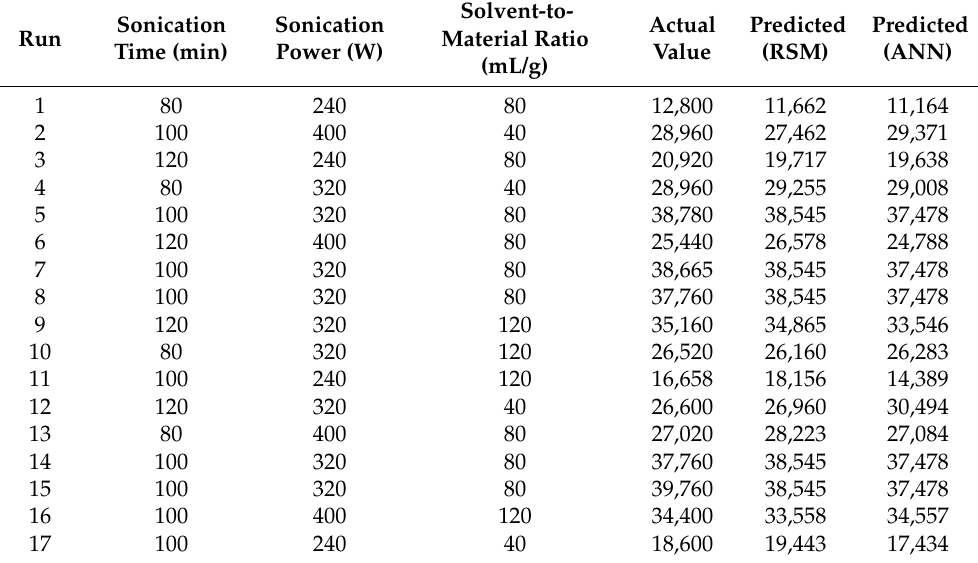
Table 4. Three variables and the peak area in D. crassirhizoma comparison between actual value, predicted RSM, and predicted ANN ( n =